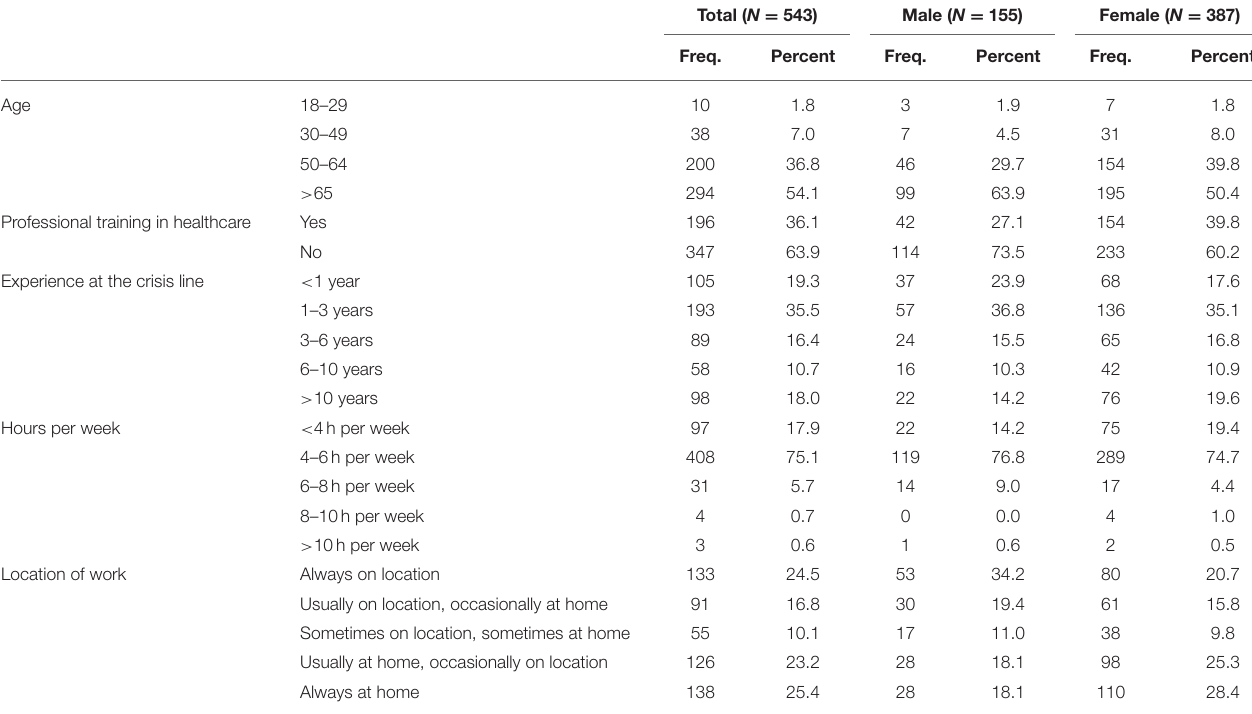
TABLE 1 | Demographics and work-related information by